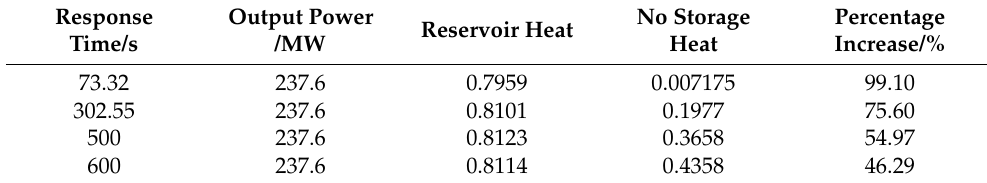
Table 1. The heat effect of the power units on the steam heating and melting salt storage heat.